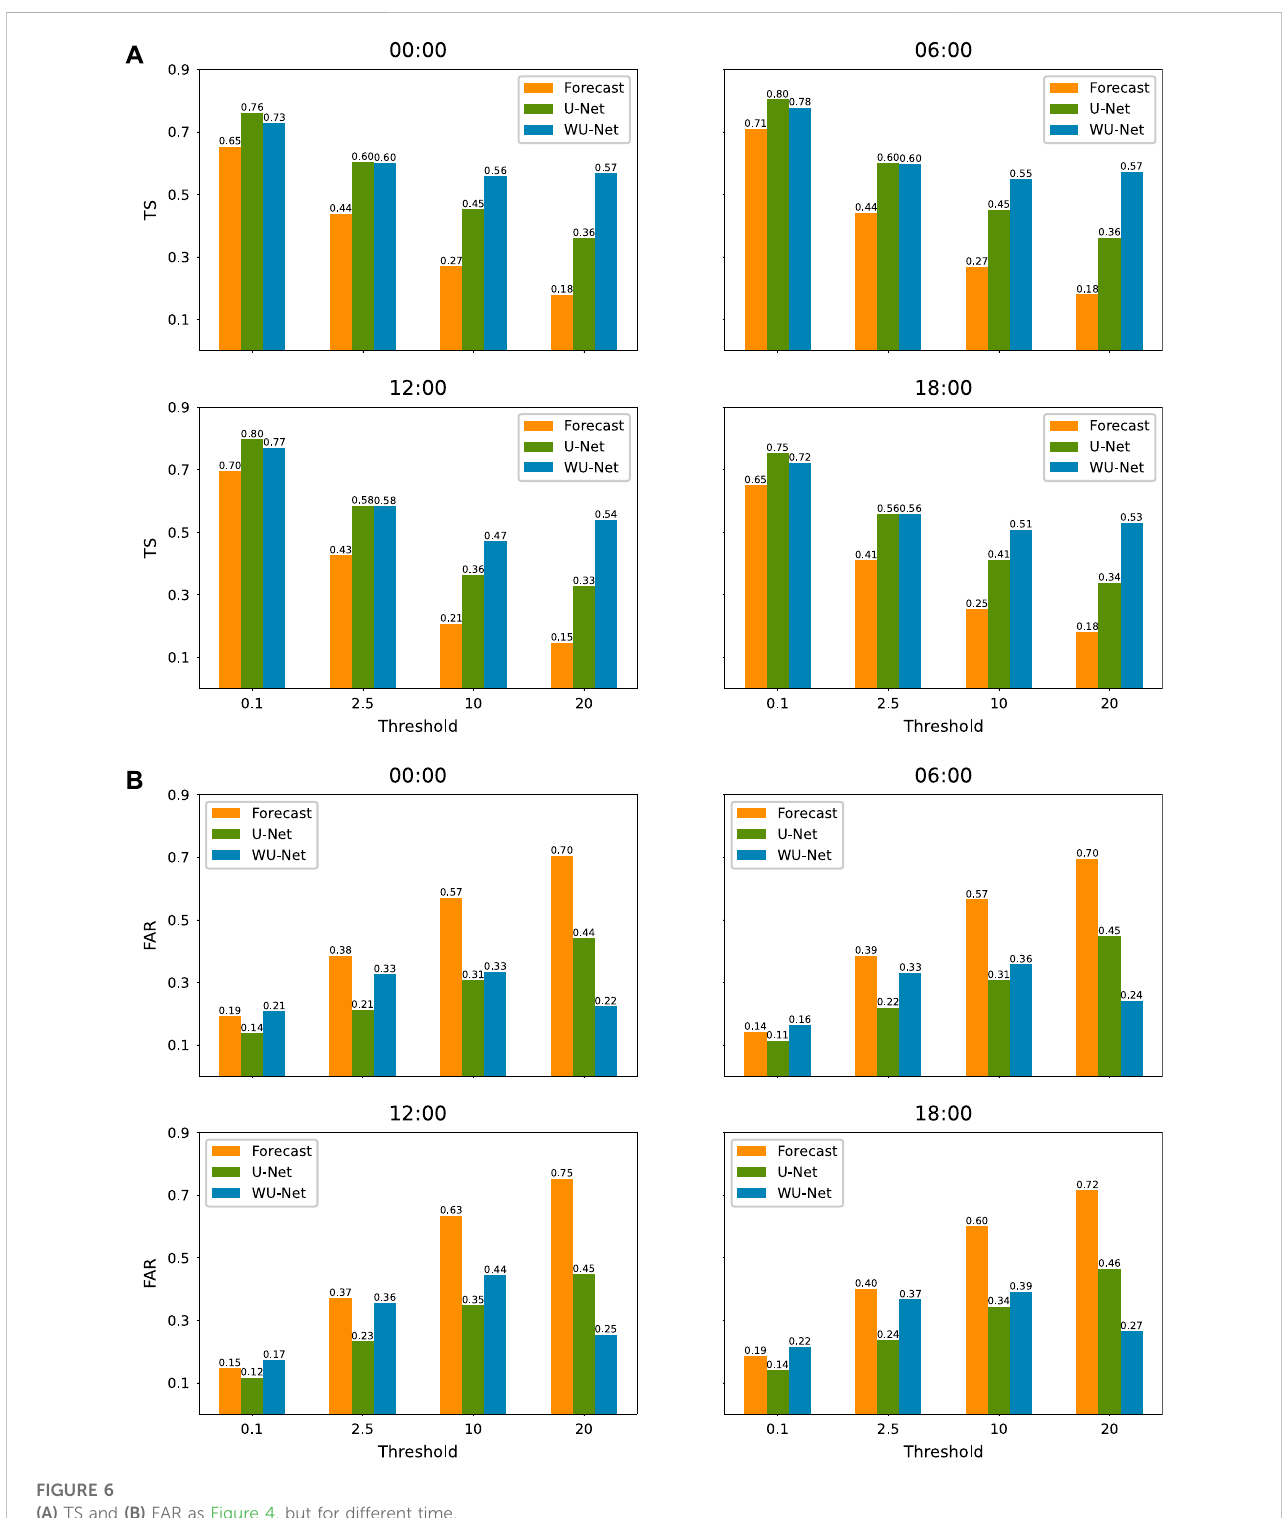
FIGURE 6 (A) TS and (B) FAR as Figure 4, but for different